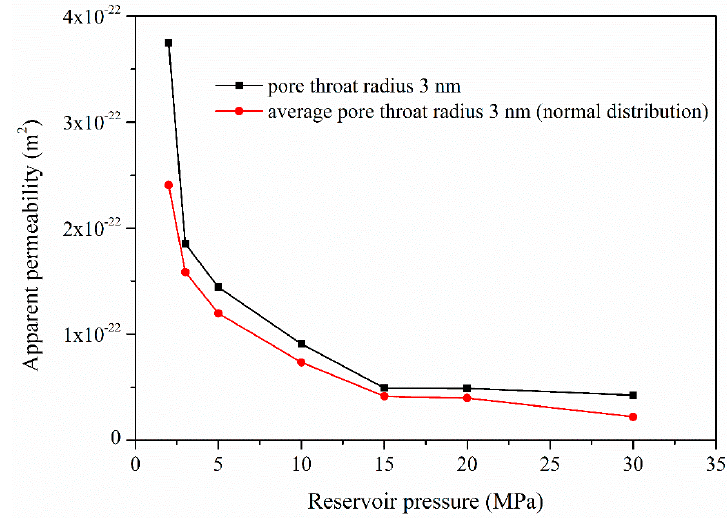
Figure 6. Variation of the apparent gas permeability with reservoir gas pressures.